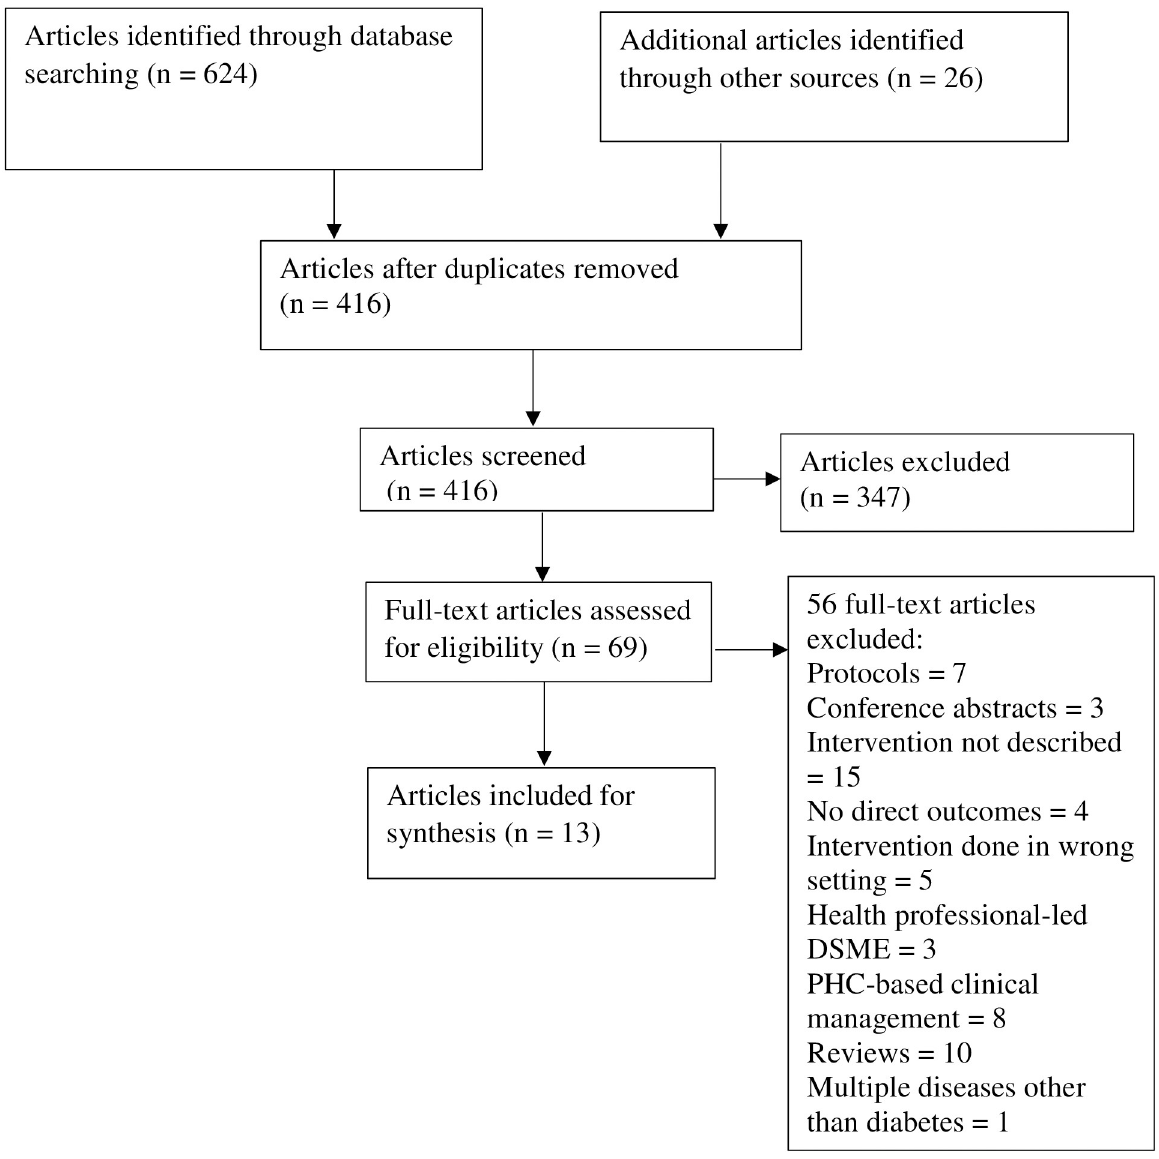
Fig 1. Literature search flow